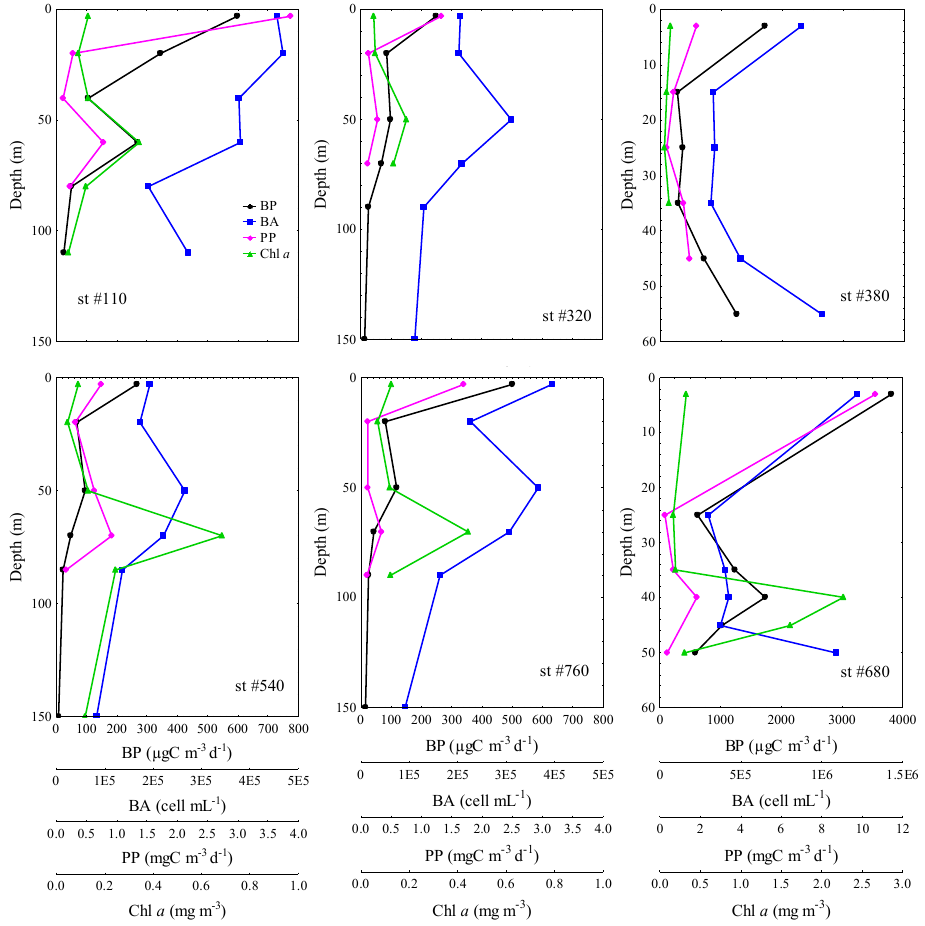
Fig. 3. Vertical profiles of bacterial production (BP, µgCm − 3 d − 1 ) , bacterial abundance (BA, × 10 5 cellml − 1 ) , primary production (PP, mgCm − 3 d − 1 ) and Chl a concentration (mgm − 3 ) in selected offshore (st #110, 320, 540 and 760) and coastal (st #380 and 680)